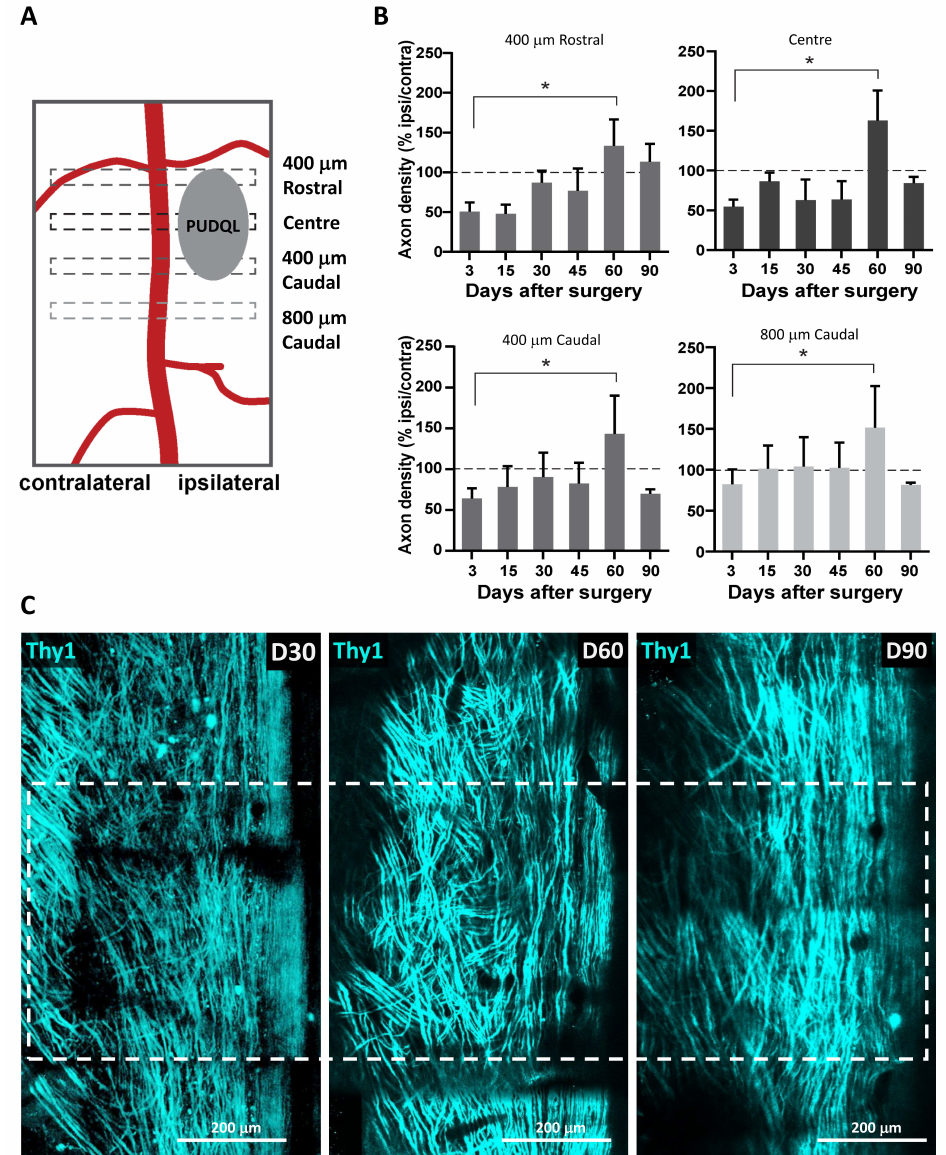
Figure 3. Spontaneous regeneration of axons following PUDQL. ( A ) Schematic representation of the regions of interest (ROIs) where axons were counted relatively to the location of the PUDQL. ( B ) Evolution of the normalized axonal density over 90 days after PUDQL (n = 5). ( C ) Representative intravital images of the same field of view centered on PUDQL. ROI corresponding to lesion epicenter is plotted (dotted square). Note the reduced axonal density at D30, the high density of tortuous axons at D60, as well as the dense network of straight axons by D90. The dense sprouting observed at the end of the second month was then pruned after three months. Data are shown as mean ± SEM. * p <